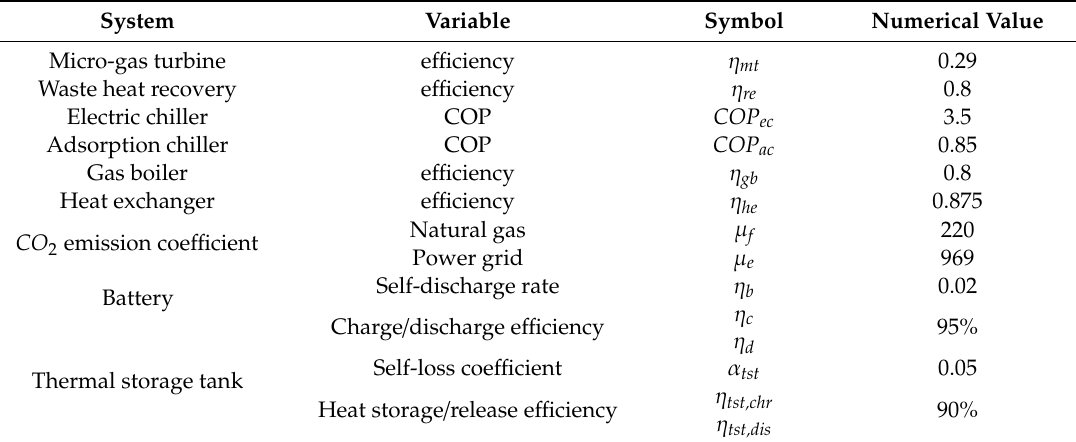
Table 4. Parameters setting of the CCHP system.